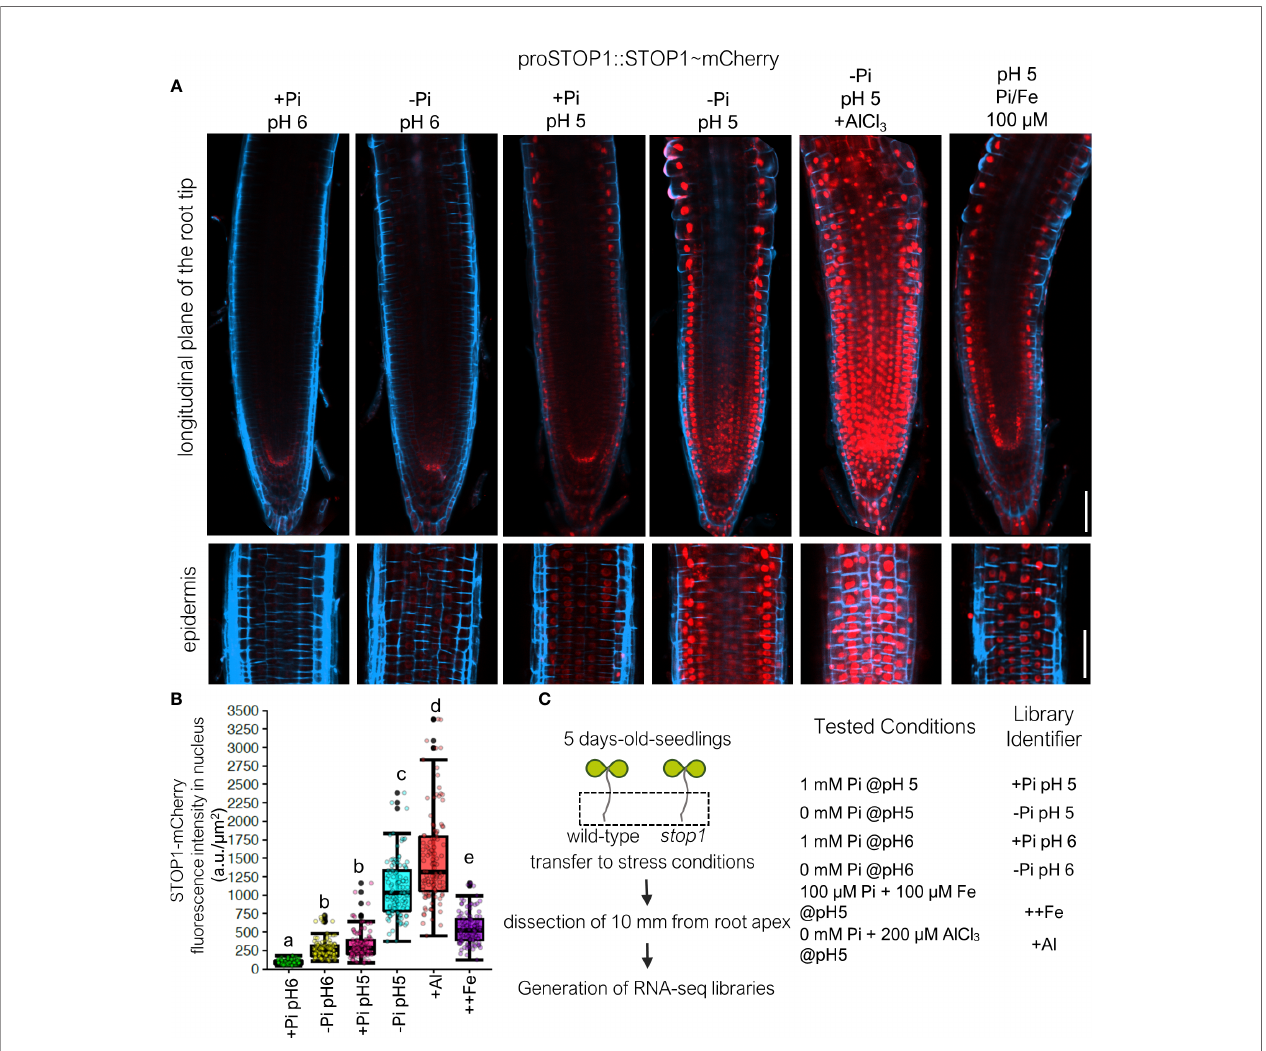
FIGURE 1 | STOP1 accumulation as a molecular marker to direct RNA-seq pro fi ling of acidic pH, low Pi, Al toxicity and Fe toxicity conditions. (A) Transgenic stop1 seedlings expressing proSTOP1::STOP1~mCherry (line #1) were grown 5 days-after-germination (dag) and then transferred to the indicated medium conditions during 16h, at this time STOP1-mCherry signal (Red Channel) was observed using confocal microscopy. The cell-wall was stained using a modi fi ed DAPI-staining (see Materials and Methods). Upper panels depict a longitudinal plane of the root apex; lower panels depict epidermis layer of the root apex. Scale bar equals 50 µM. (B) Quanti fi cation of STOP1-mCherry signal in the nucleus of epidermal cells under the tested conditions in 2 biological replicates using 2 independent transgenic stop1 seedlings expressing proSTOP1::STOP1~mCherry with 3 technical replicates. A total of n=112 nuclei per condition were measured. Statistical groups are represented by letters and were determined using a Tukey HSD test (P-val <.05). (C) RNA-seq pro fi ling experimental strategy and